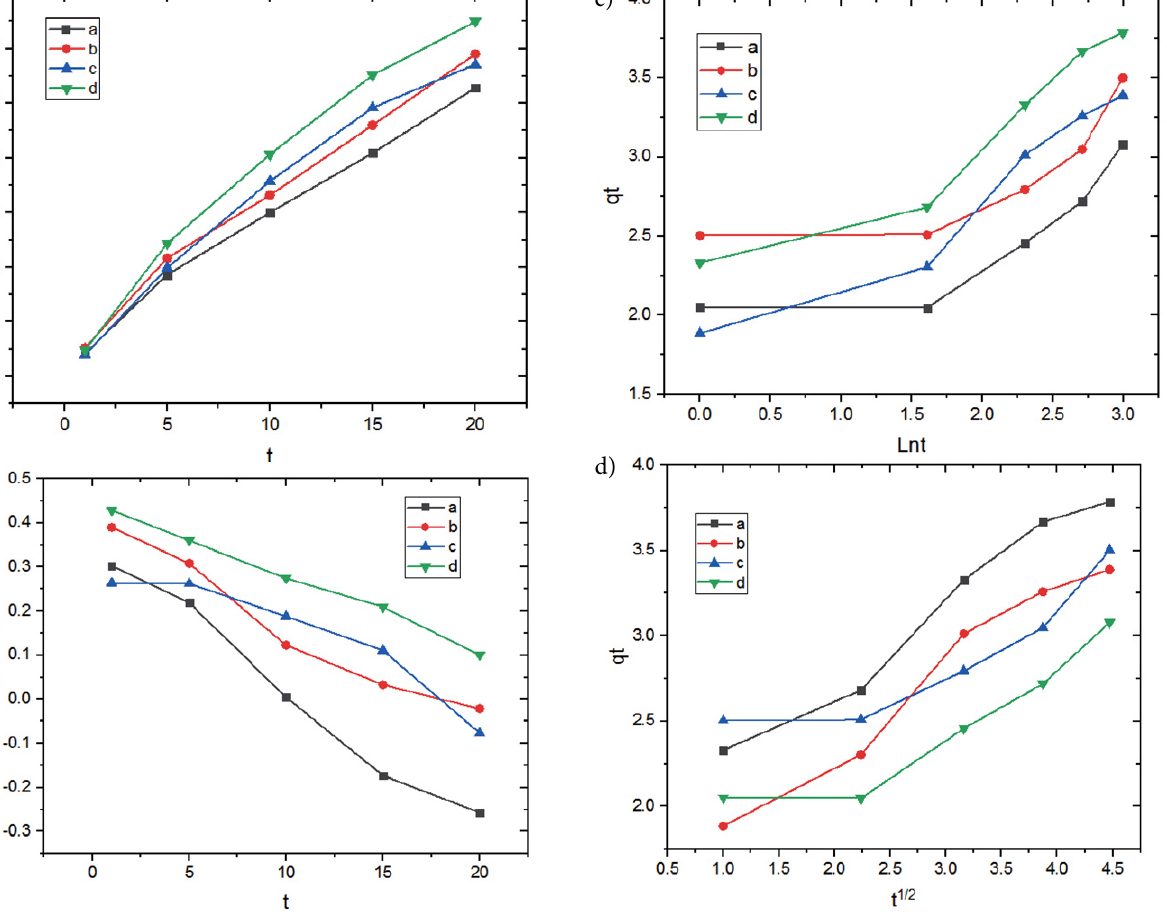
Figure 13. The kinetics models plot for DOX adsorption a (Dosage =1.6 gr / L, λ max = 482) b (Dosage =1.6 gr / L, λ max = 292) c (Dosage = 0.8 gr / L, λ max = 482 ) d ( Dosage = 0.8 gr / L, λ max = 290) A, B, C, D pseudo-second kinetic model, pseudo-first kinetic model, intra-particle diffusion model, Elovich model,